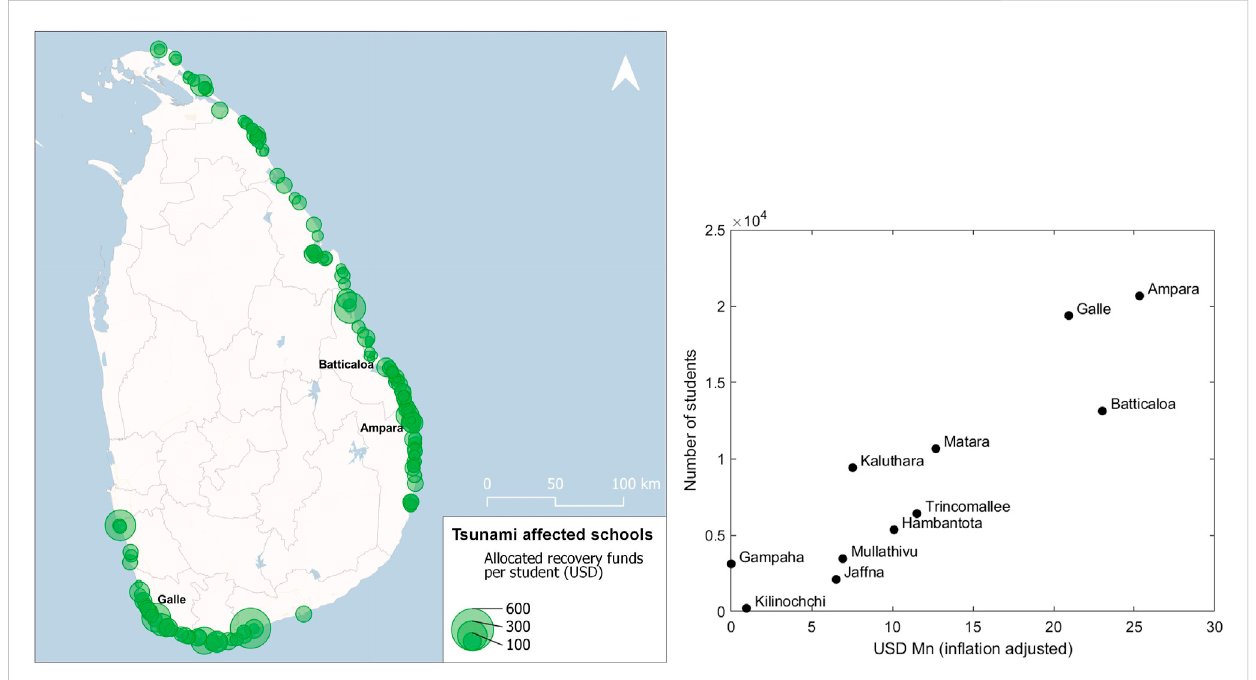
height ranges: low (less than 0.5 m), medium (between 0.5m and 2 m), and high (greater than 2